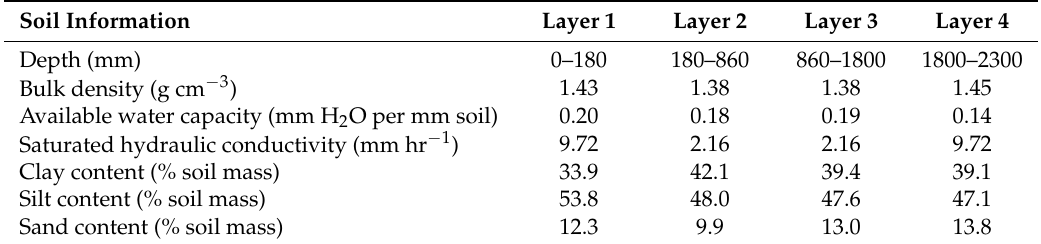
Table 2. Soil information from the Soil Survey Geographic Database (SSURGO) used in model setup.